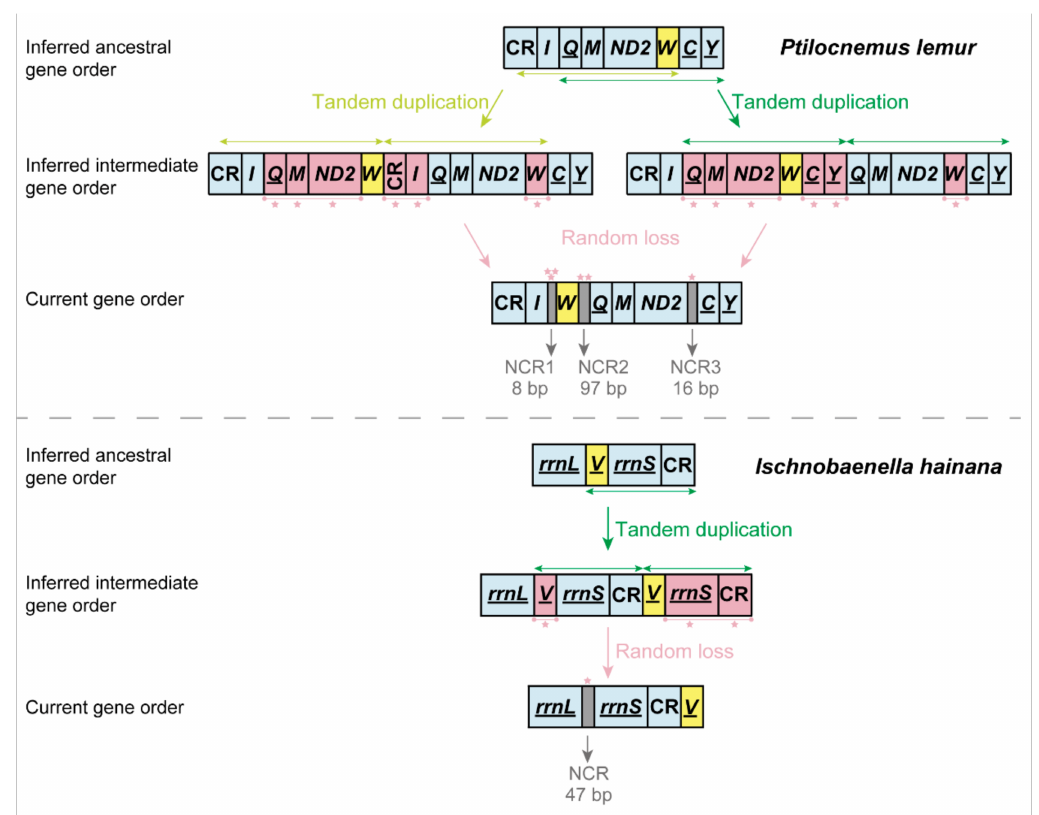
Figure 4. The inferred process of translocation of trnW ( P. lemur ) and trnV ( I. hainana ). CR: control region; NCR: non-coding region. Genes marked with underline are located on the minority